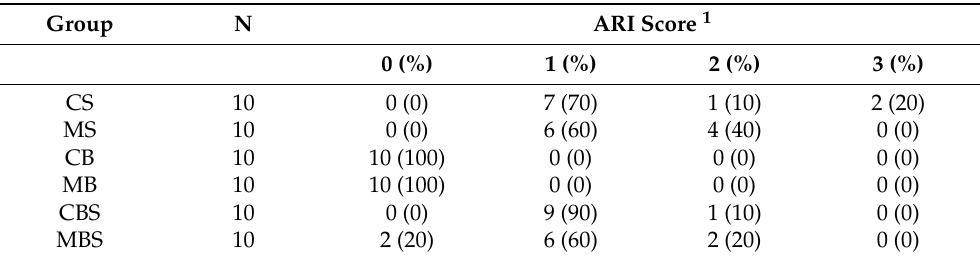
Table 3. The distribution of frequency and percentage of adhesive remnant index (ARI) scores of each group.